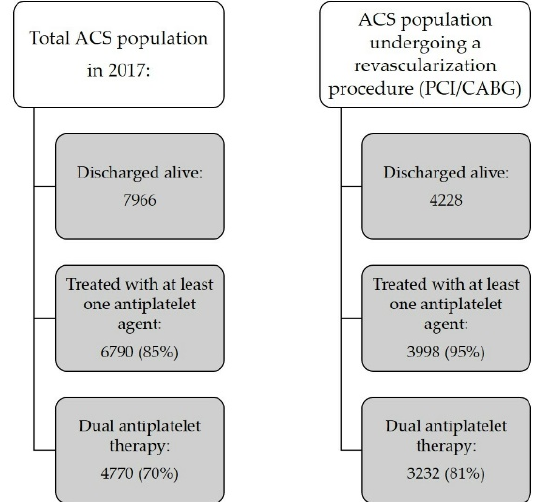
Figure 2. Prevalence of overall and dual antiplatelet therapy in the entire acute coronary syndrome (ACS) population and in those undergoing percutaneous (PCI) or surgical (CABG) revascularization.